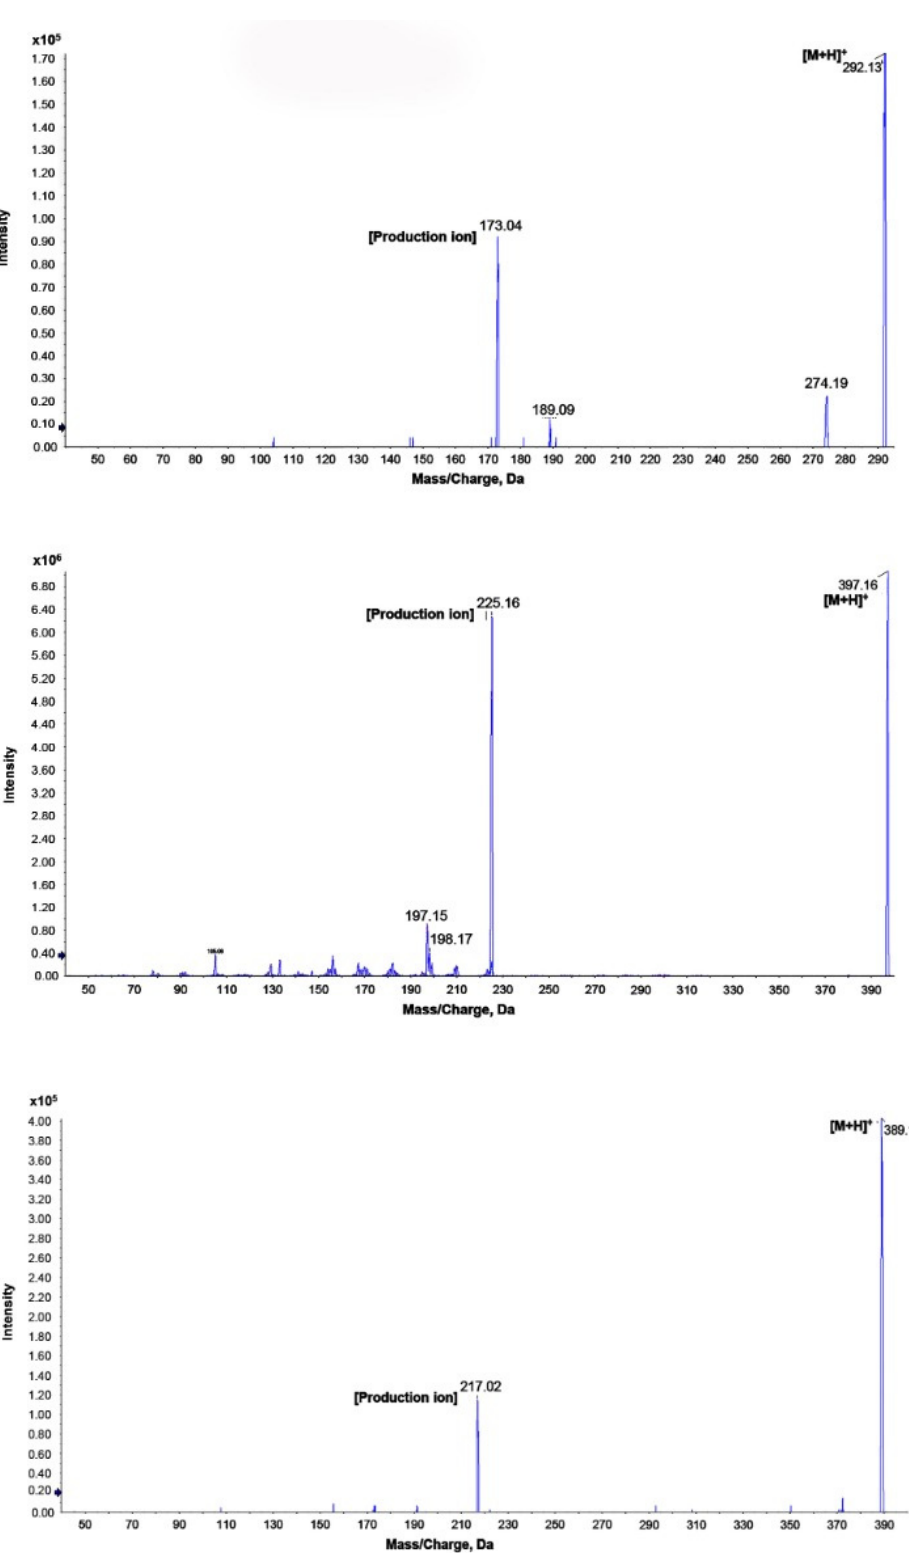
Figure 4. Representative mass spectra for AW-9a, WES-1, and WES-2 by the proposed liquid chromatography (LC)-MS/MS method.